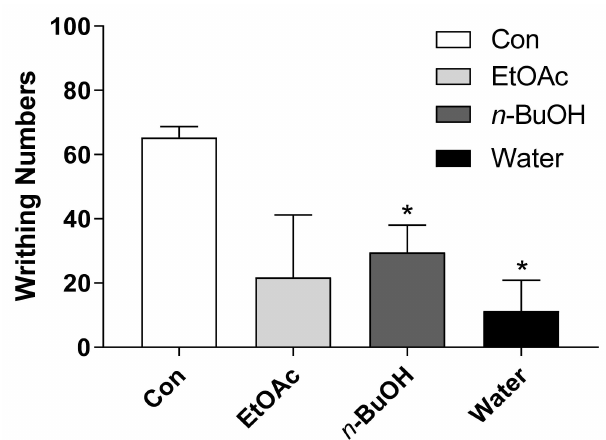
Figure 7. Effect of Symplocos chinensis f. pilosa Ohwi water extract (SCW) solvent fractions in the acetic acid-induced abdominal writhing test. Data are expressed as mean ± SD; n = 4 mice per group. (* p < 0.001 vs. control